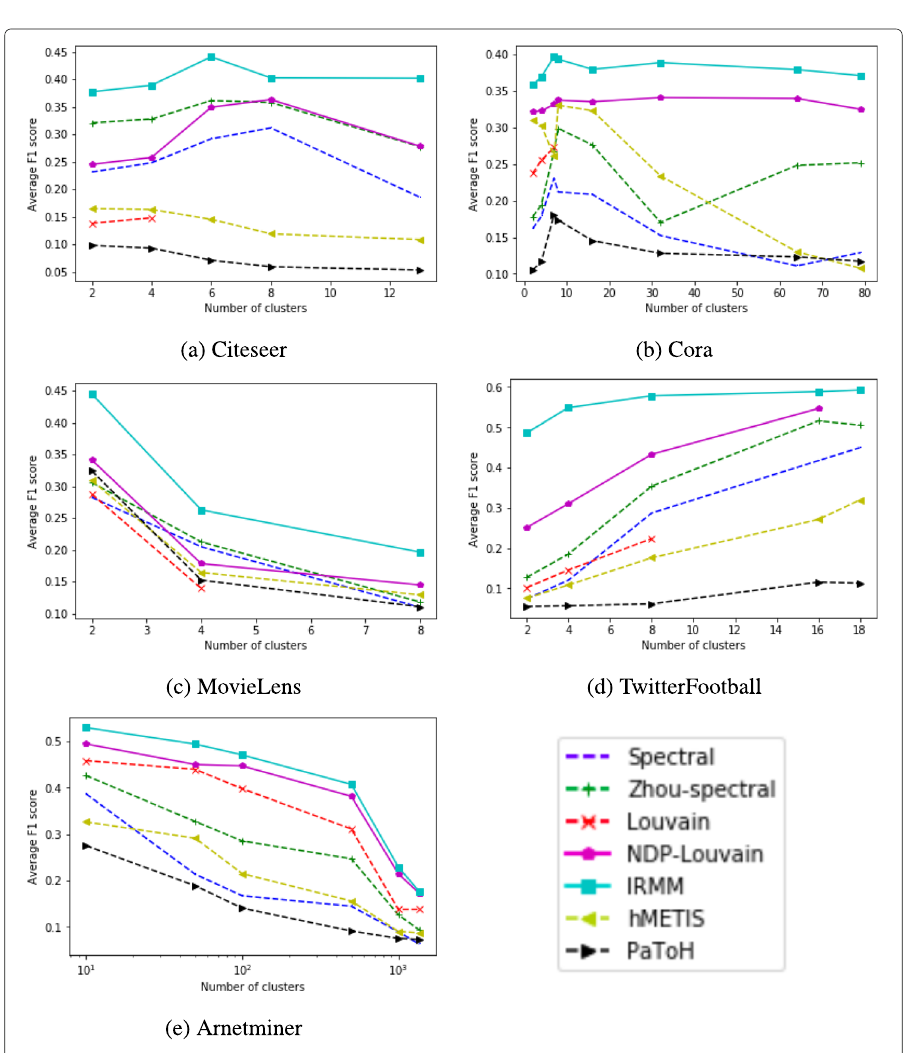
Fig. 3 F1 scores for varying number of clusters. Here, x-axis represent the number of clusters and y-axis indicates F1